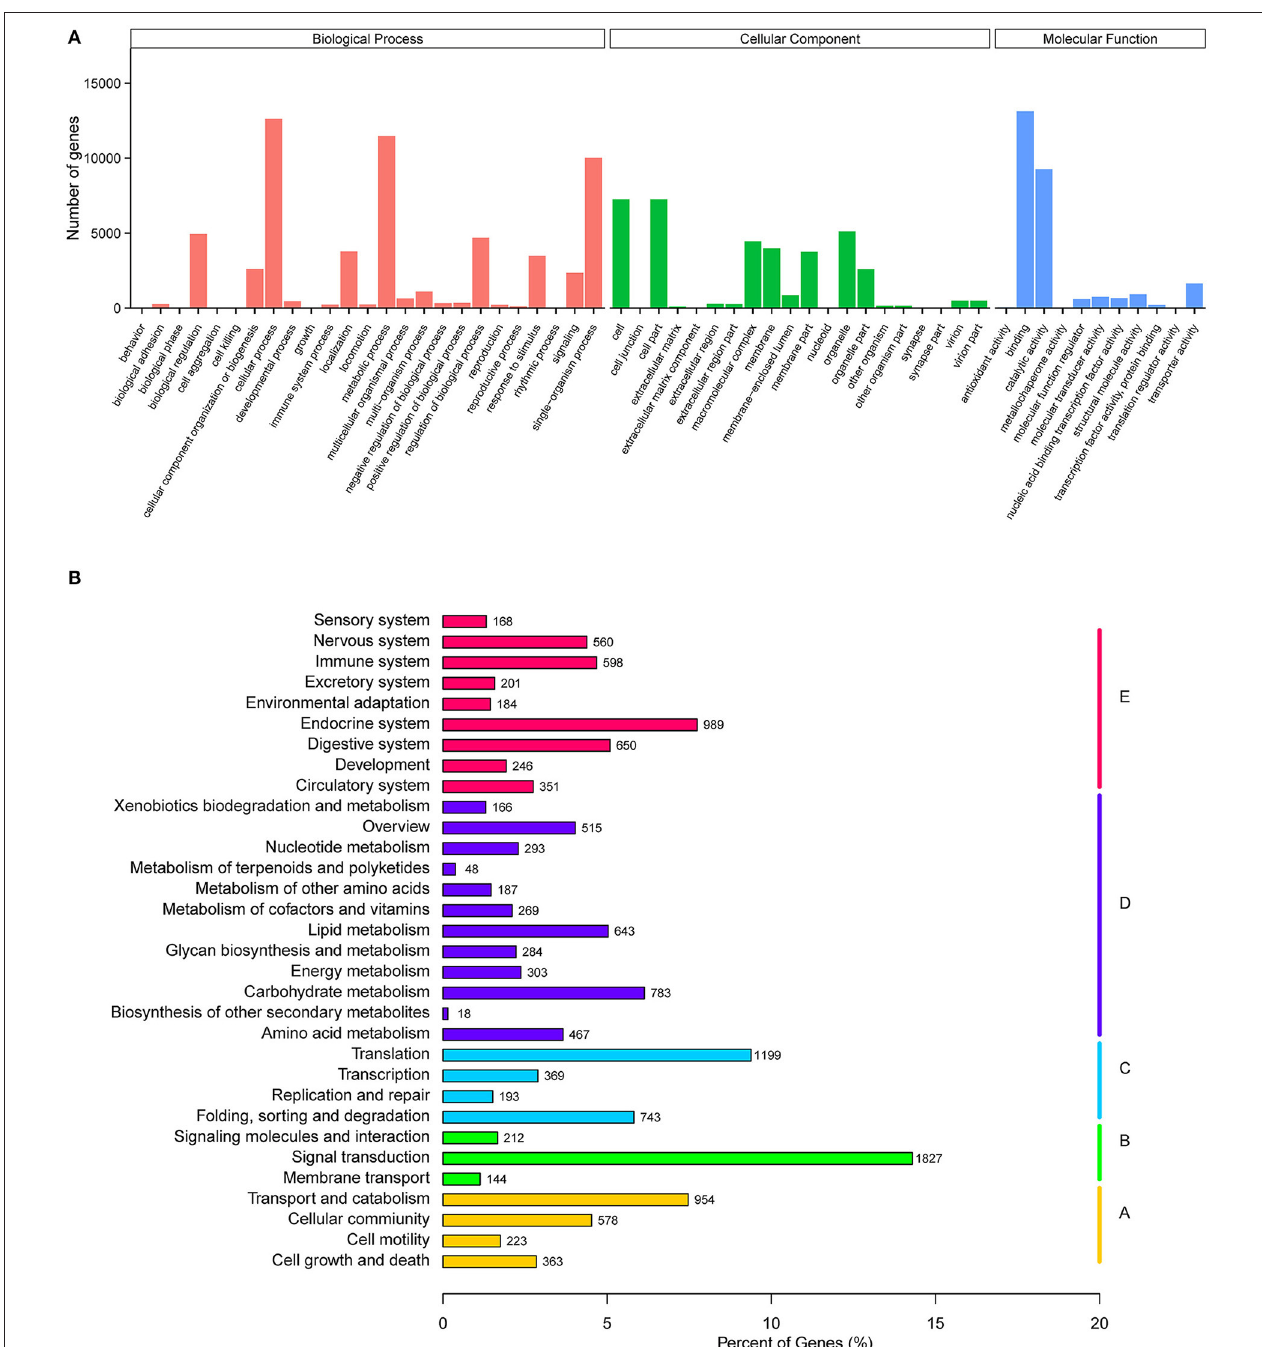
FIGURE 1 | Functional annotation of A. chinensis unigenes. (A) Gene ontology (GO) classification of A. chinensis unigenes. (B) Kyoto Encyclopedia of Genes and Genomes (KEGG) classification of A. chinensis